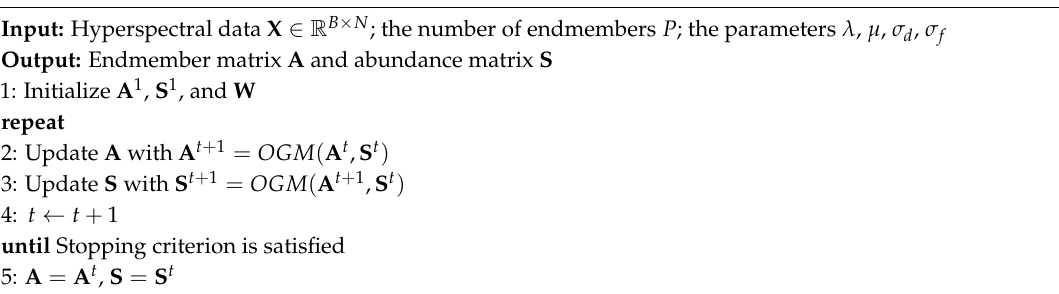
Algorithm 2 Bilateral Filter Regularized L 2 Sparse NMF (BF- L 2 SNMF) for